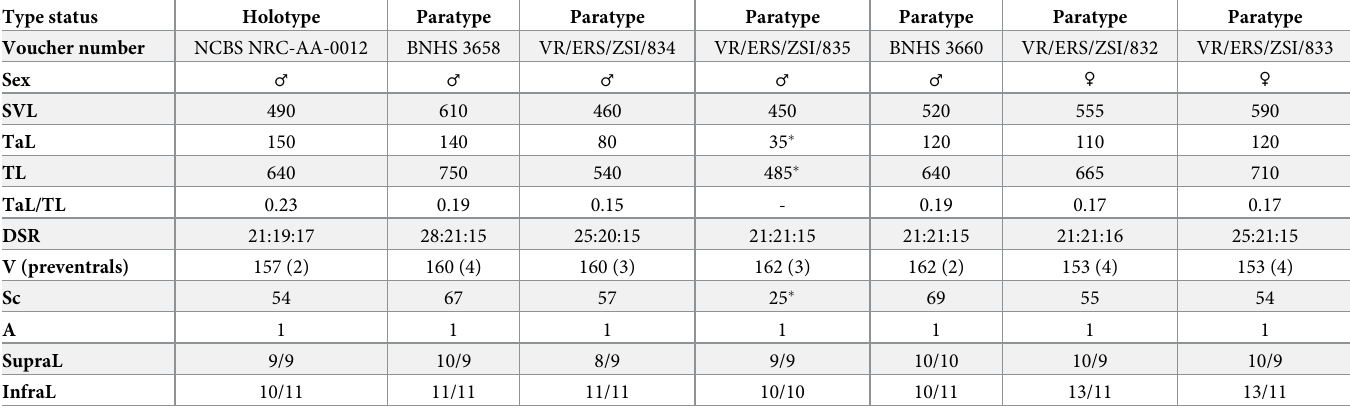
Values bearing ‘ � ’ indicate